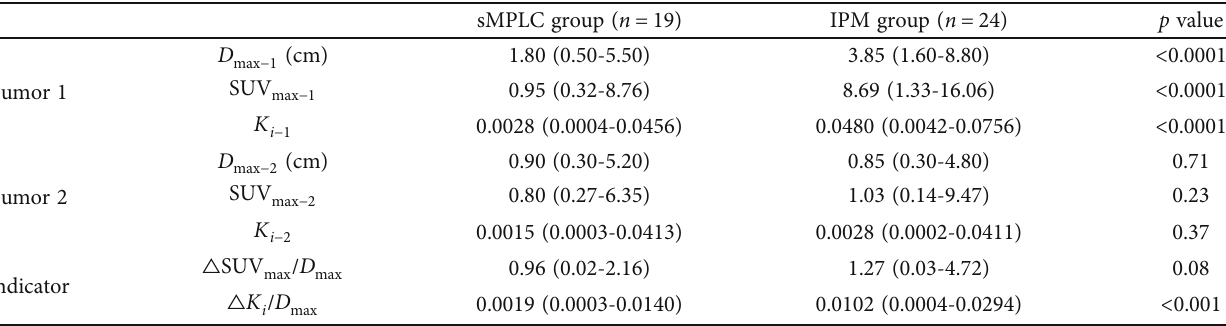
Table 2: Statistical results of the sMPLC and IPM